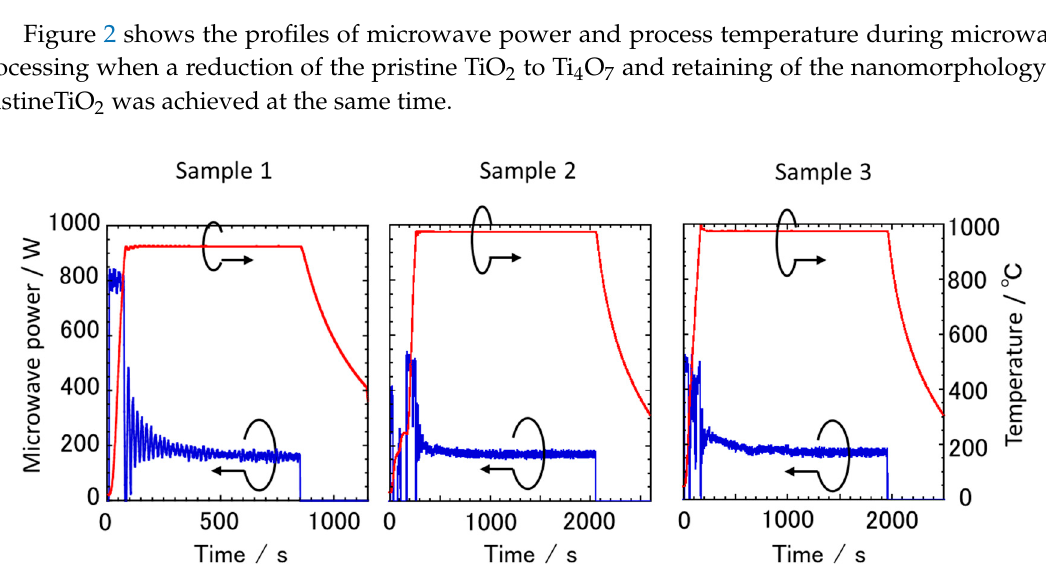
Figure 2. Temperature and microwave power profiles in microwave processing. Table 2. Experimental conditions in microwave processing.